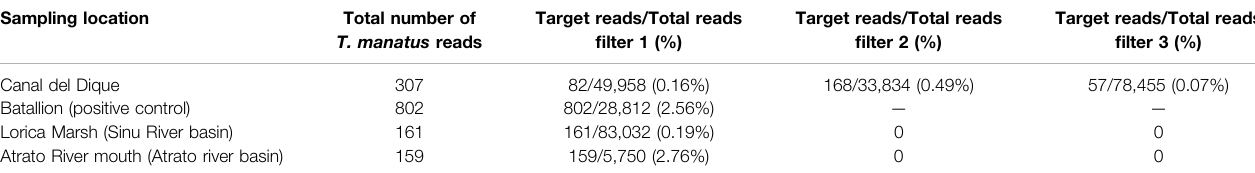
TABLE 5| Positive T.manatus eDNAdetectionsin fi lterscollectedinfouroutof18possibleColombianlocations.Thetargetsequence wasthehypervariable 12sRNAgene inthe mtDNA. Thetotal ofreads detected ineach fi lterisalso showedaswell asthepercentage correspondingtothe T.manautus manatus reads regarding the totalfor the fi lter. Filter numbers corresponds here to the n th positive fi lter for the location rather than to the correct number of said fi lter. Sampling